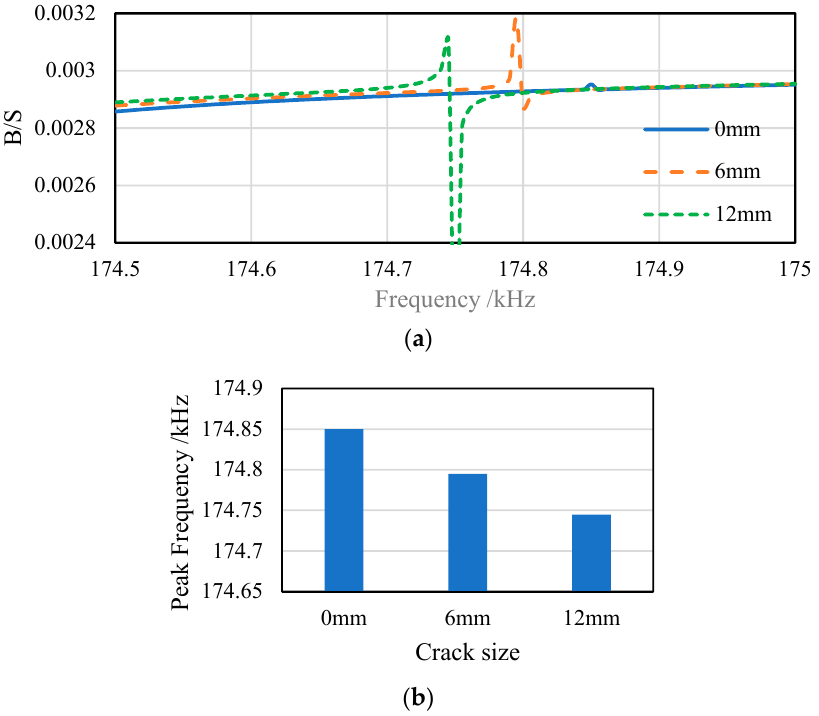
Figure 6. Numerical simulation results ( a ) piezoelectric admittance spectrum and ( b ) peak frequency tendencies in 174.5 kHz–175 kHz with different crack sizes.